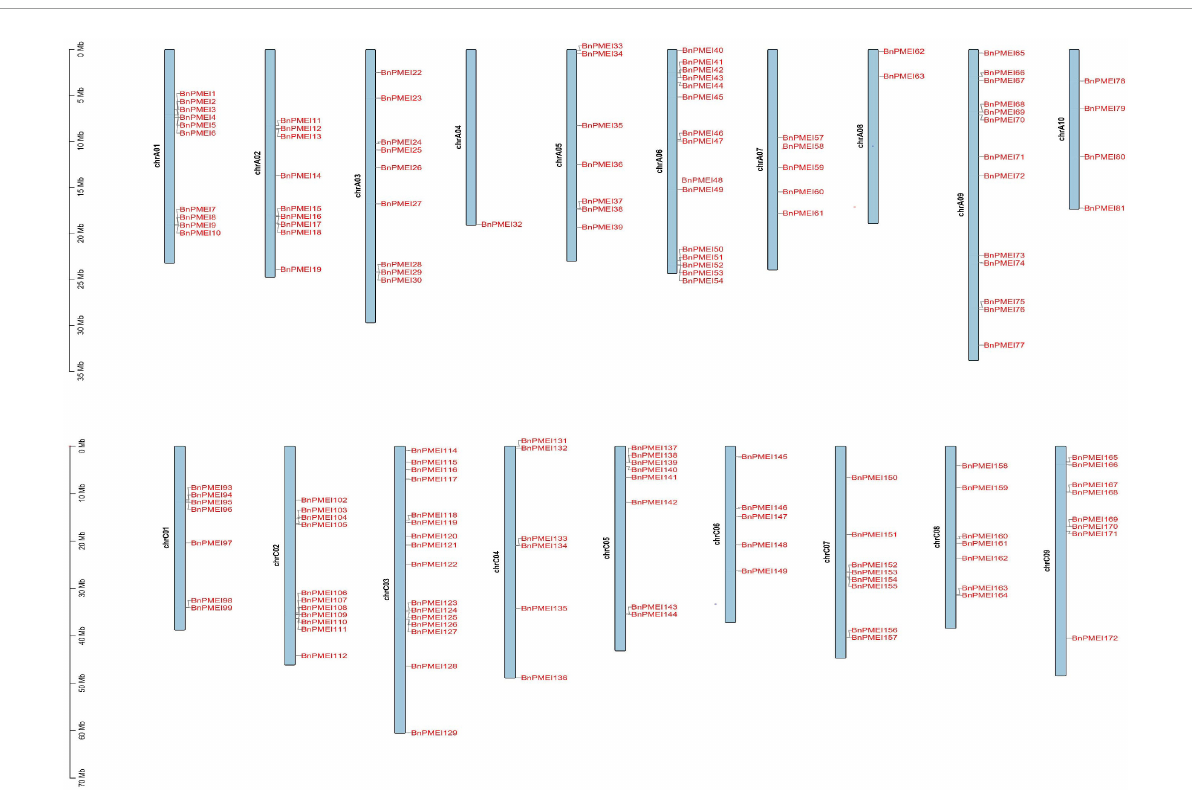
FIGURE3 The distribution of BnPMEI genes on B. napus chromosomes. A total of 151 BnPMEI genes were mapped to the 19 chromosomes, and the remaining BnPMEI genes were unassembled scaffolds. The chromosome number was indicated on the left side of each chromosome and gene names were shown on the right side of each chromosome. The scale was megabases (Mb). Chr,